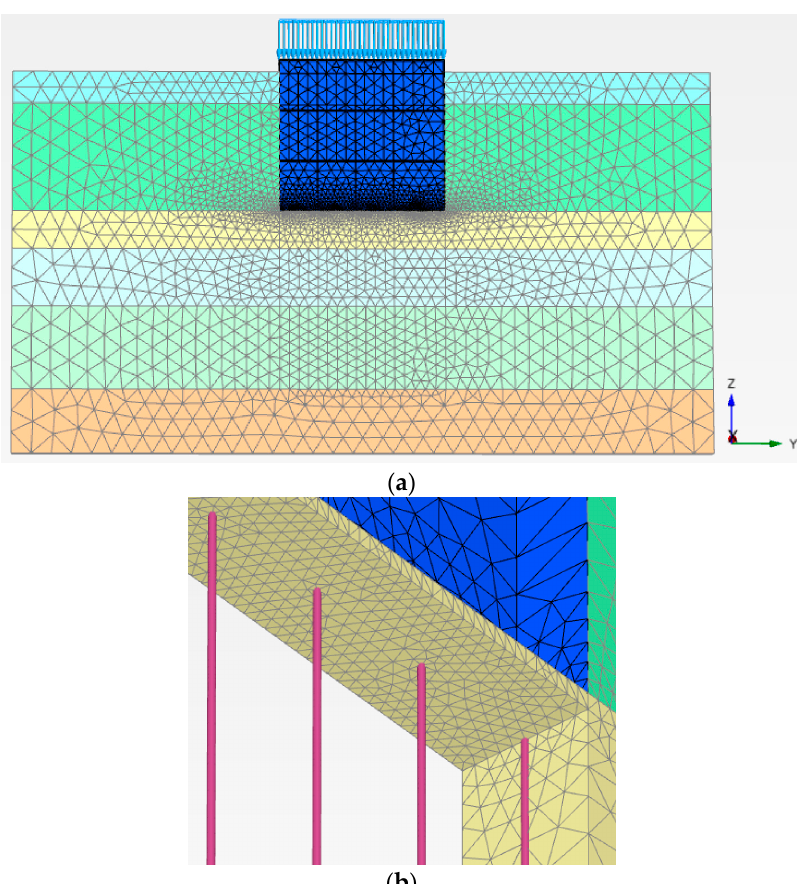
Figure 6. Model mesh of single-row pile: ( a ) integral model diagram; ( b ) partial enlarged detail.